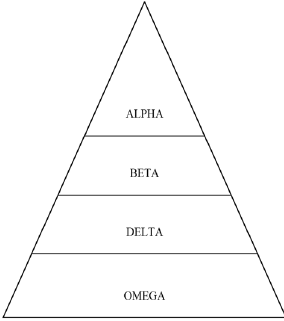
Figure 2. Social hierarchy of wolves and their characteristics in